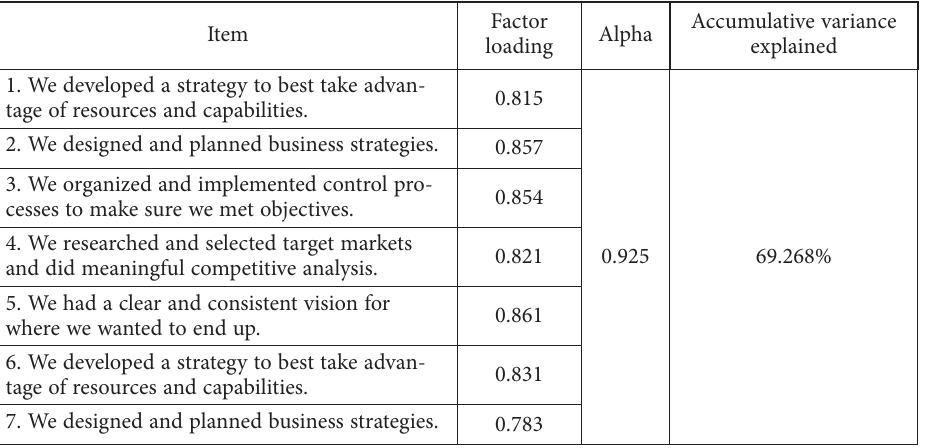
Table 3. The reliability and validity of causation items